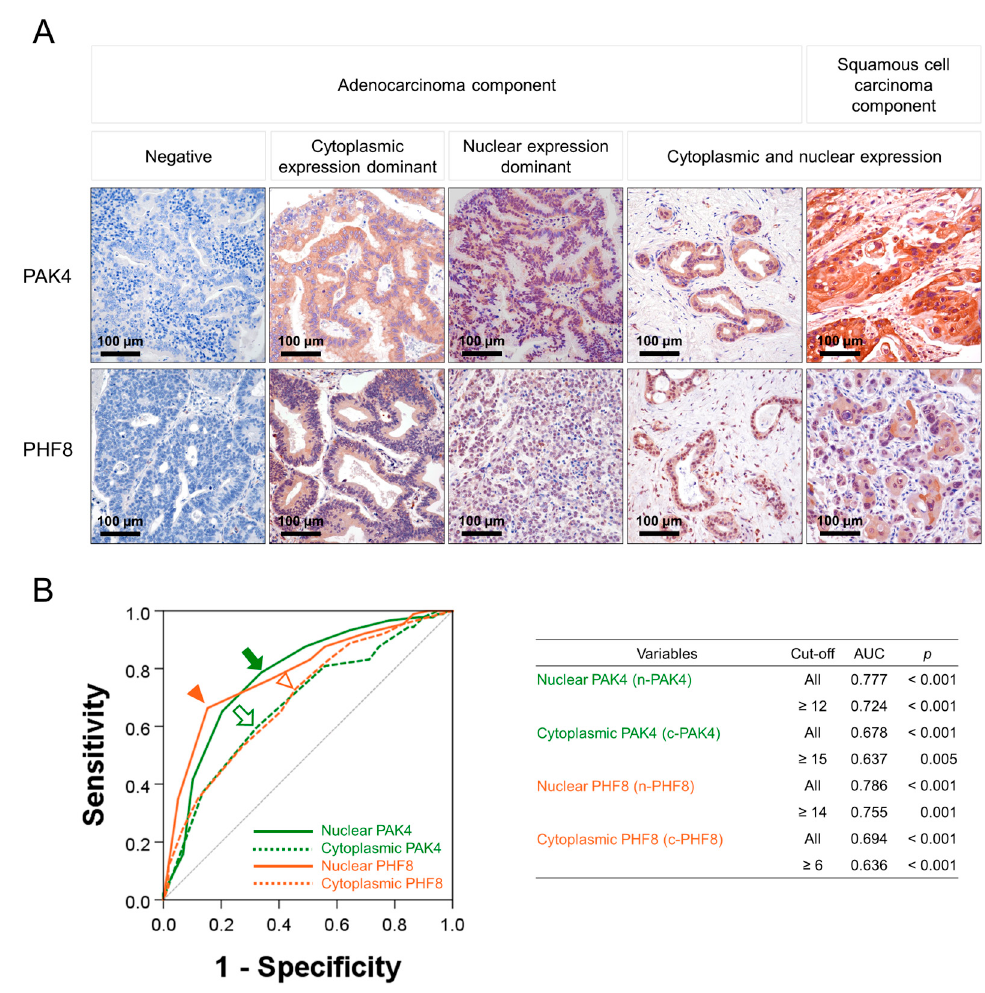
Figure 1. Immunohistochemical expression of PAK4 and PHF8 in human GBCs. ( A ) PAK4 and PHF8 are expressed in the nuclei and cytoplasm of GBC cells. Original magnification: × 400. ( B ) Receiver operating characteristic curve analysis to determine cut-off points of immunohistochemical expression of PAK4 and PHF8. The cut-off point was determined at the point with the highest area under the curve (AUC). Green arrow (nuclear expression of PAK4, n-PAK4), empty green arrow (cytoplasmic expression of PAK4, c-PAK4), orange arrowhead (nuclear expression of PHF8, n-PHF8), and empty green arrowhead (cytoplasmic expression of PHF8, c-PHF8) indicate the cut-off points.